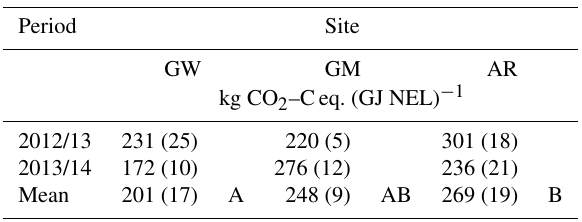
Figure 6. Annual emissions of CH 4 (a) and N 2 O (b) at the four study sites combined for 3 years (April 2011–March 2014) of mea- surement ( n = 24). Different capital letters indicate significant dif- ferences between the sites ( p <0.05). Table 4. Annual GHG balances (CO 2 , CH 4 and N 2 O fluxes, slurry C and harvested C) of the three agricultural study sites in relation to energy yield (net energy lactation, NEL). Different capital letters indicate significant differences between the sites ( p <0.05). Values in brackets are standard errors ( n = 3).